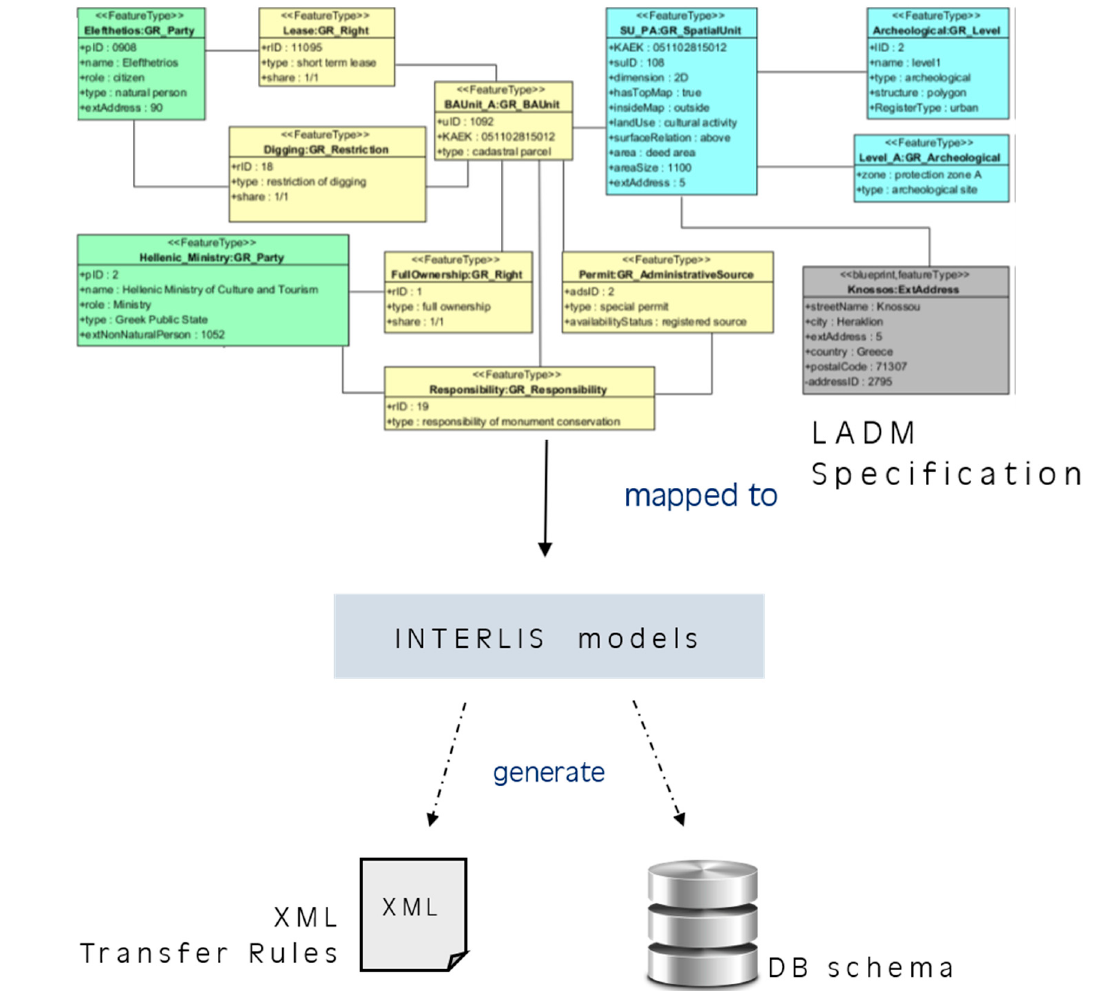
Figure 4. INTERLIS “duality” (adopted from [6], edited).